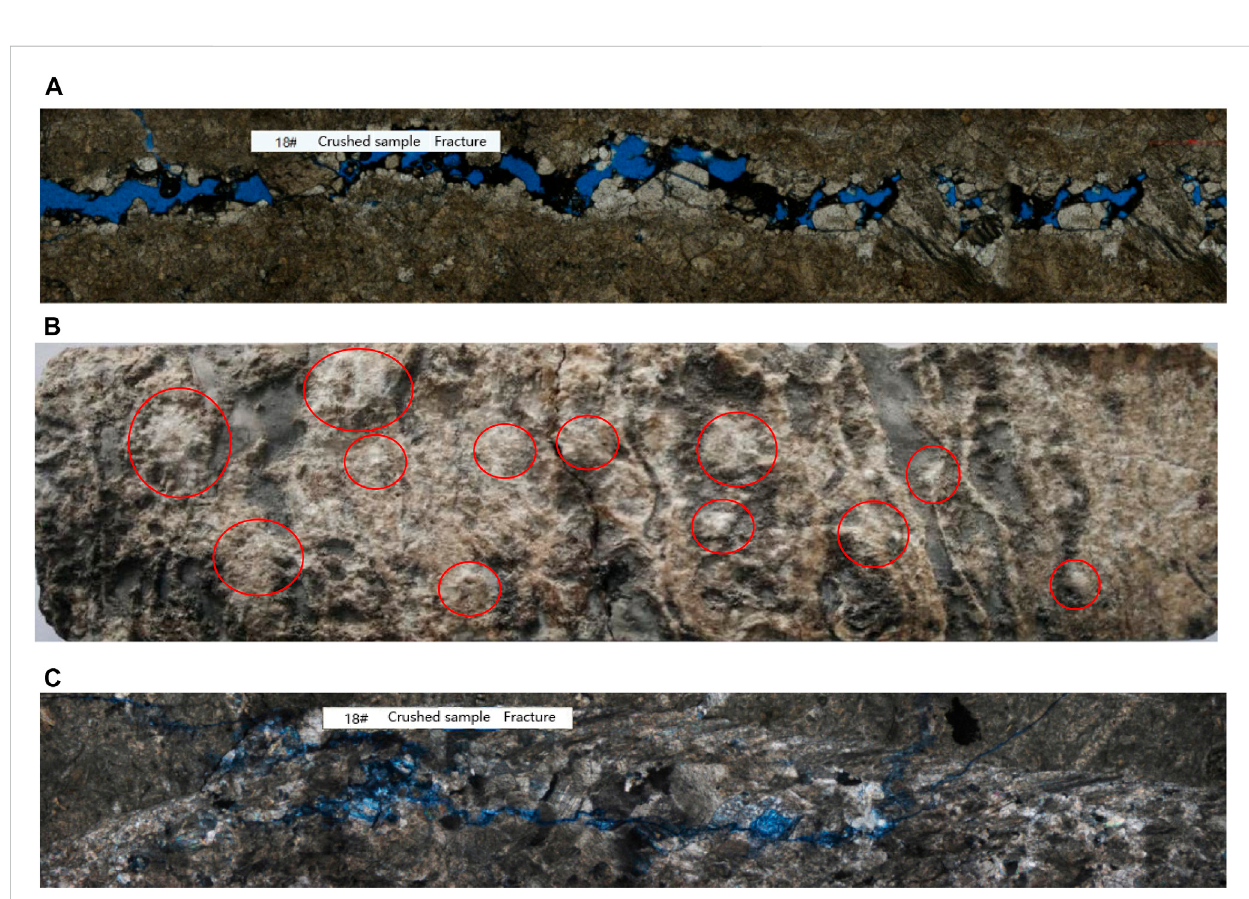
FIGURE 12 The microconvex body of wall breakage. (A) : fracture wall, (B) : microconvex body, (C) : fracture